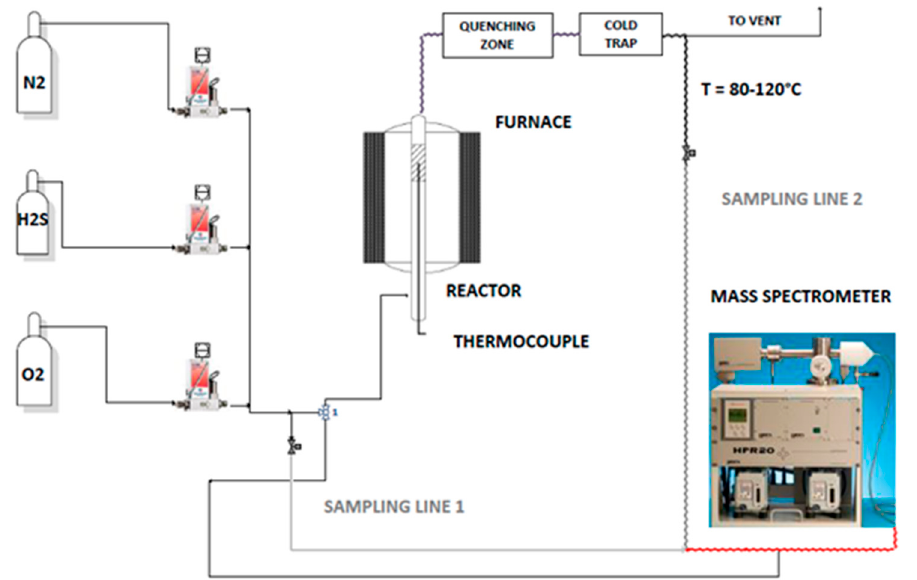
Figure 8. Scheme of the laboratory plant.